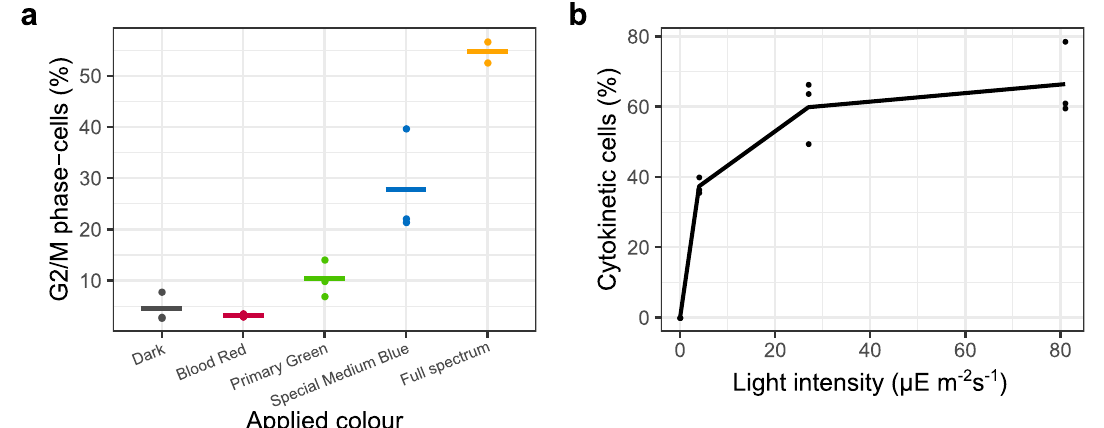
Figure 3. Light requirements for mitotic cell cycle progression ( a) Percentage of cells in G2-M phase of the cell cycle after 9 h of illumination with different light spectra or darkness, determined with flow cytometry using SYBR green. Points represent individual replicates, while horizontal lines show the average for each condition. ( b) Proportion of cytokinetic cells at different light intensities, measured 12 h after the end of dark arrest. In the dark, no cytokinetic cells were observed. Points represent individual data points while the line connects the average percentage for each blue-light response. When the data were analyzed by sexual cell stage, full spectrum, cyan and green light led to an increase of gametes and zygotes compared to the dark and red light ( p < 0.001) (Fig. 2b, Supplementary